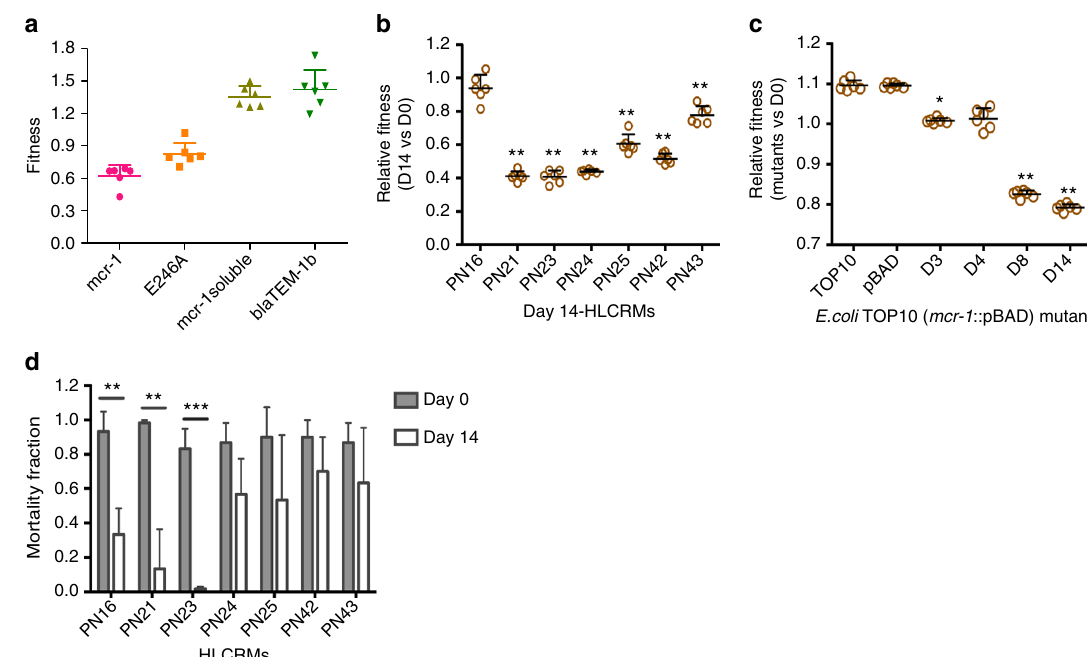
Fig. 6 Competition assays and G. mellonella killing models in HLCRMs. a Fitness of full-length mcr-1 , calalytically inactivated mcr-1 (E246A), and mcr-1 soluble domain. Fitness of blaTEM-1b as a negative control. b Relative fi tness of wild-type mcr-1 -positive strains and their derivatives. c Relative fi tness of mcr-1/ pBAD-positive E.coli TOP10 strains and their derivatives. In all fi tness fi gures, error bars represent the SD ( n = 6). The differences in fi tness were tested using non-parametric Mann – Whitney test, * indicates 0.01 < p value < 0.05 and ** indicates p value < 0.01. The average relative fi tness and p values are listed in Supplementary Table 6. d HLCRMs displays impaired virulence in the G. mellonella infection models. All results represent means of three independent experiments with 10 larvae per treatment. Mortality bar charts were plotted using the Kaplan – Meier method (GraphPad Software). Error bars represent the SD ( n = 3) and p value for strains PN16 ( p = 0.0056, t = 5.427, d.f = 4), PN21 ( p = 0.0029, t = 6.509, d.f = 4) and PN23 ( p = 0.0003, t = 2.183, d.f = 4) were calculated by student t test. ** indicates 0.001 < p value < 0.01, *** indicates p value < 0.001